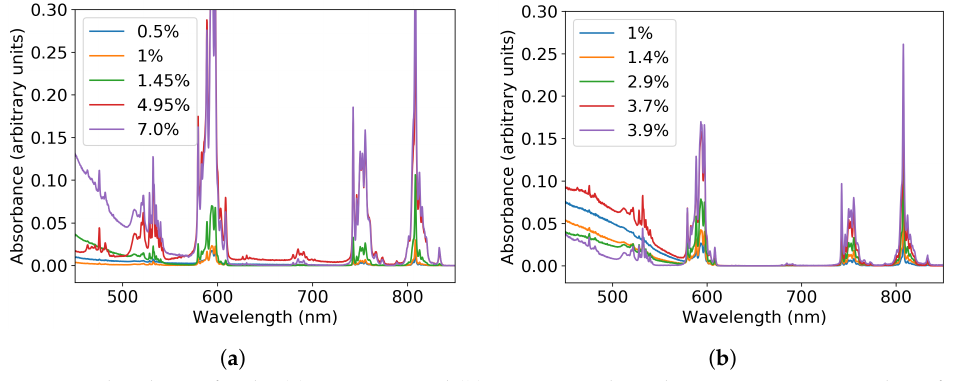
Figure 11. Absorbance for the ( a ) GA series and ( b ) GV series where the concentrations are those from the EDX measurements except for 0.5% and both 1%